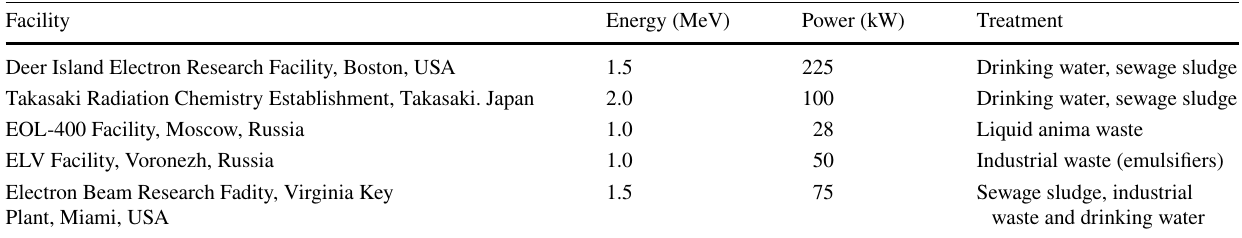
Table 3 Globally available electron beam (EB) water treatment facilities. Source: Woods and Pikaev (1994) and Bradley (1984) Facility Energy (MeV) Power